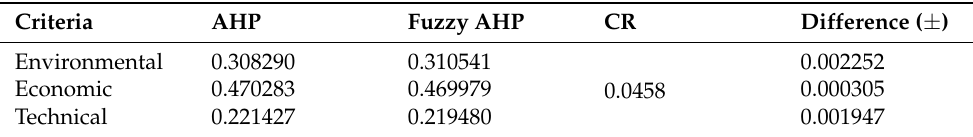
Table 3. Criteria weights on using AHP and fuzzy AHP